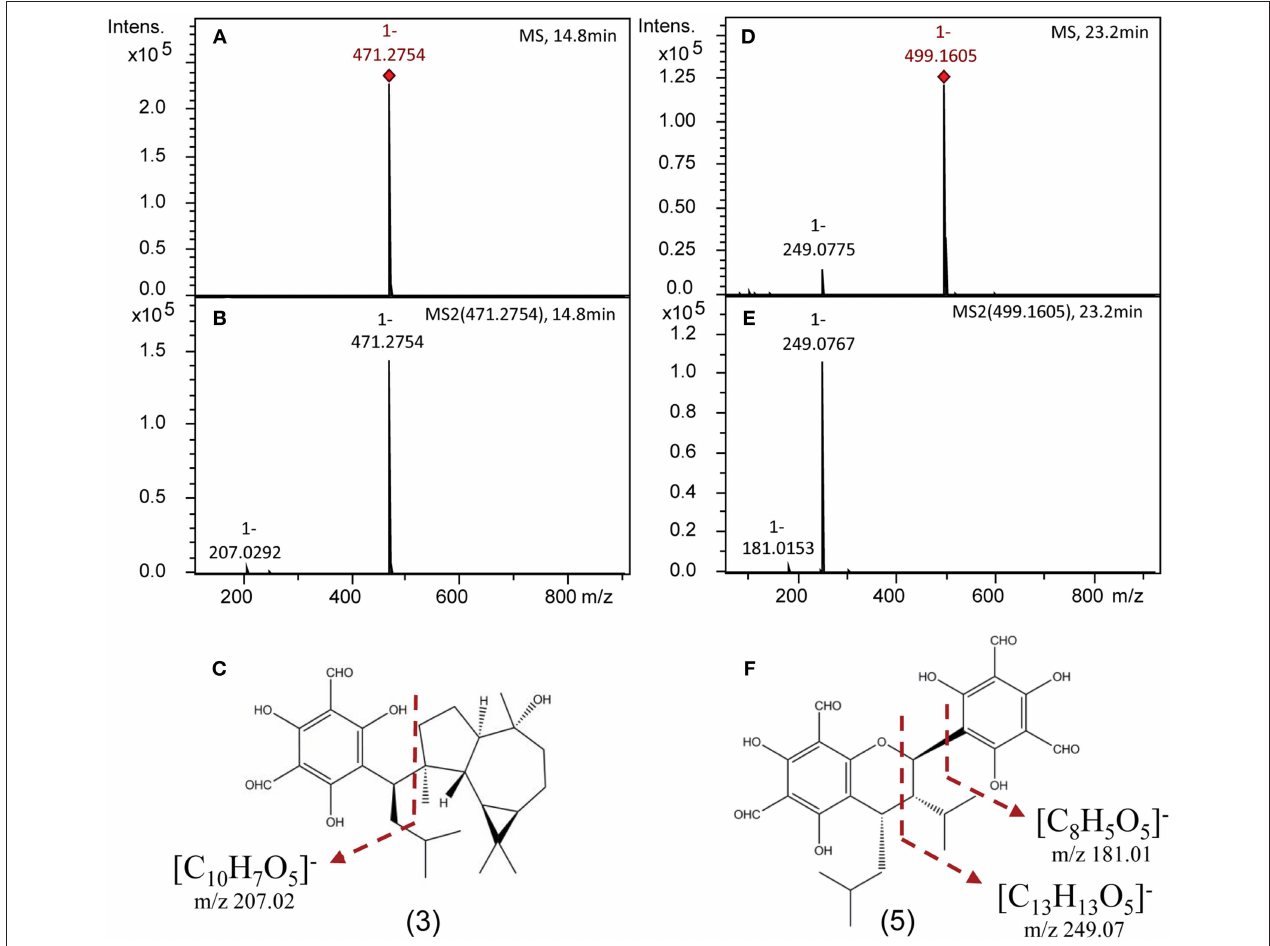
FIGURE 3 | Representative negative ion mode mass spectra of FPCs based on authentic analytical standards obtained on a ESI-Q-TOF-MS/MS. (A) Full scan mass spectrum [M-H] − of 3 . (B) Tandem MS (MS 2 ) spectrum of 3 . (C) Structural position of the diagnostic fragment for macrocarpals, m/z 207. (D) Full scan mass spectrum [M-H] − of 5 . (E) Tandem MS (MS 2 ) spectrum of 5 . (F) Structural position of the diagnostic fragments for sideroxylonals, m/z 249 and